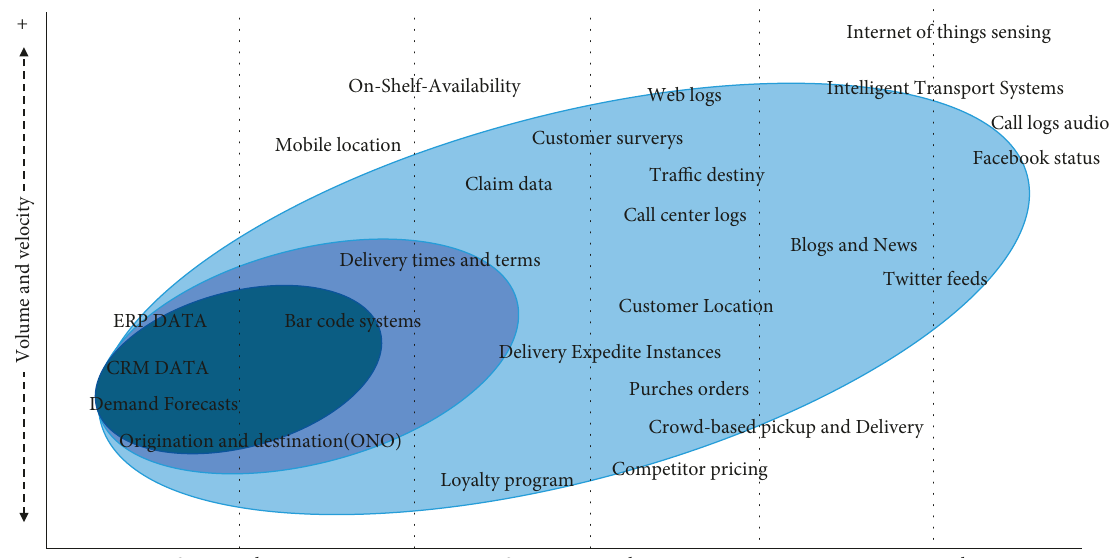
Figure 1: The development of big data sources and